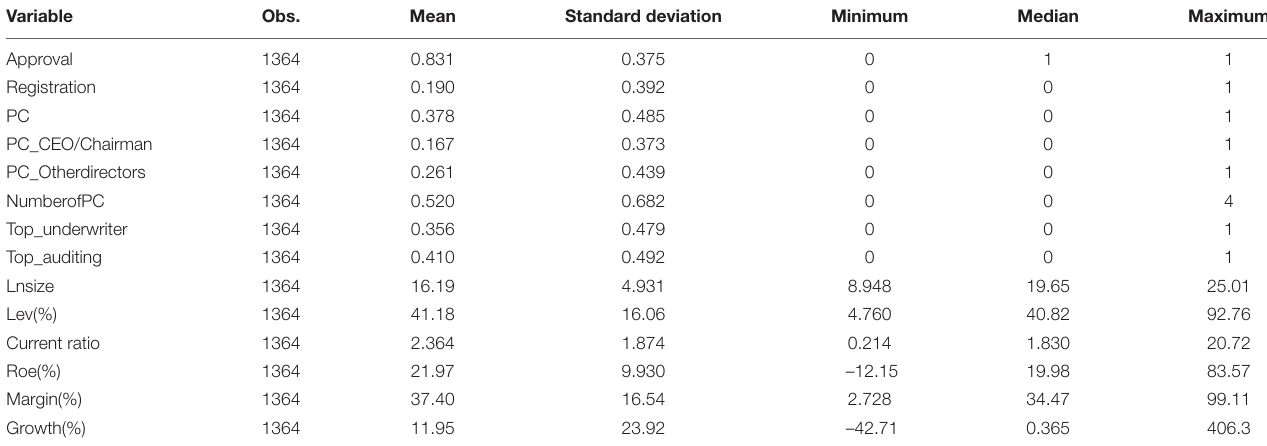
TABLE 1 | Summary statistics.